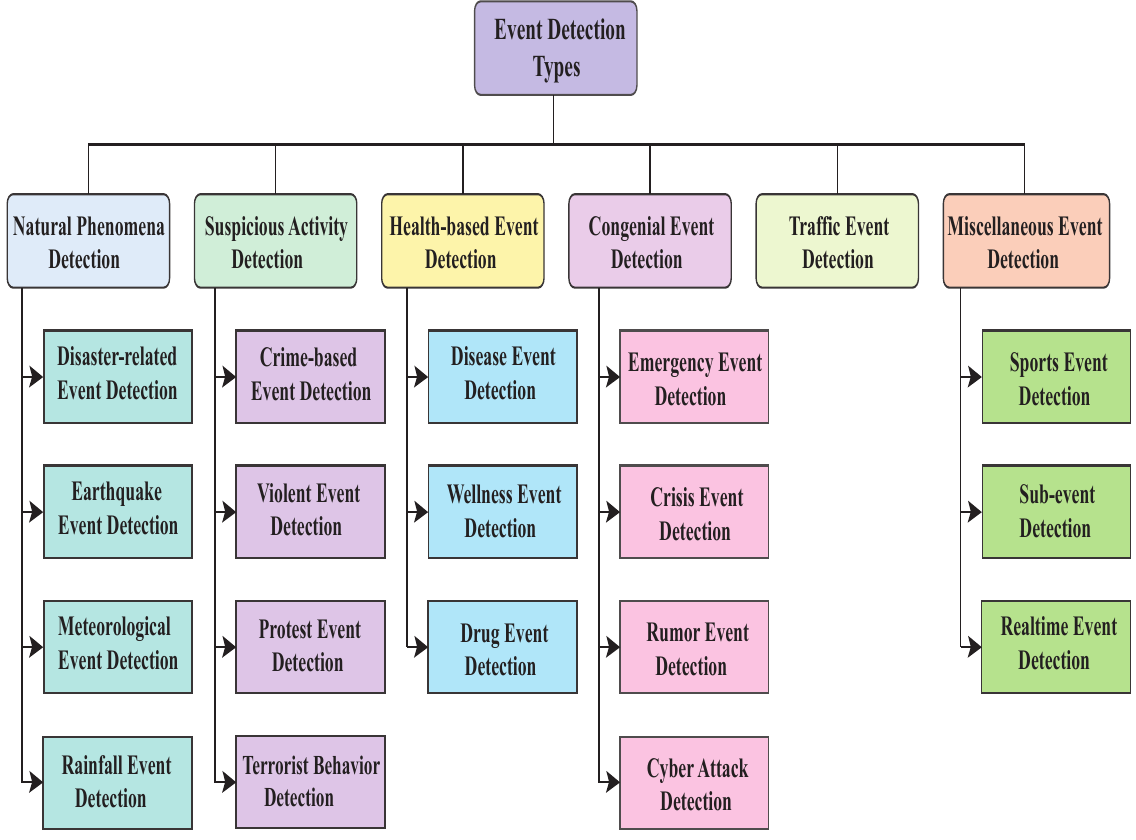
Figure 1. Different varieties of detected events observed in our studied articles during the survey of event detection from social media